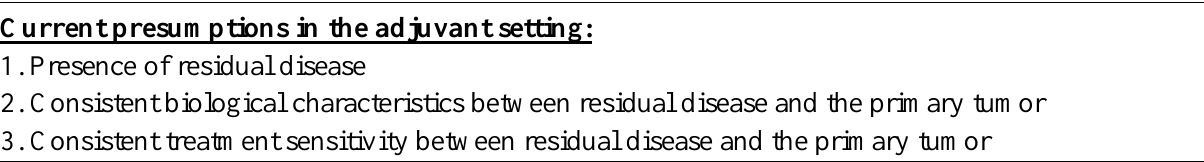
Table 1. Early breast cancer: presumptions made in the adjuvant setting regarding the presence and characteristics of